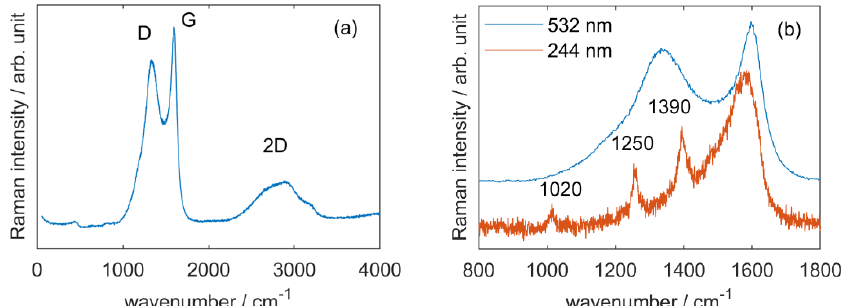
Figure 1. Raman spectra of ( a ) CSNP (λ ex = 532 nm) and ( b ) Visible (blue line) and UV (red line) Raman spectra of [Mn III ]@CSNP (λ ex = 532 and 244 nm). The Raman spectra were corrected with a linear baseline to fit D and G bands with a Lorentzian function and a Breit-Wigner-Fano function, respectively [34]. Then, the intensity ratio I D /I G was determined at 532 nm. A very low laser power (~80 µW) was used at 532 nm to preserve the sample from any degradation. Deep UV Raman spectroscopy was performed according the protocol described by Montagnac et al. [35].